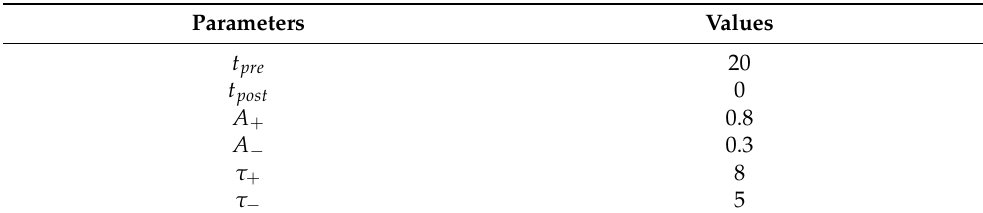
Table 2. Learning Parameters of STDP.